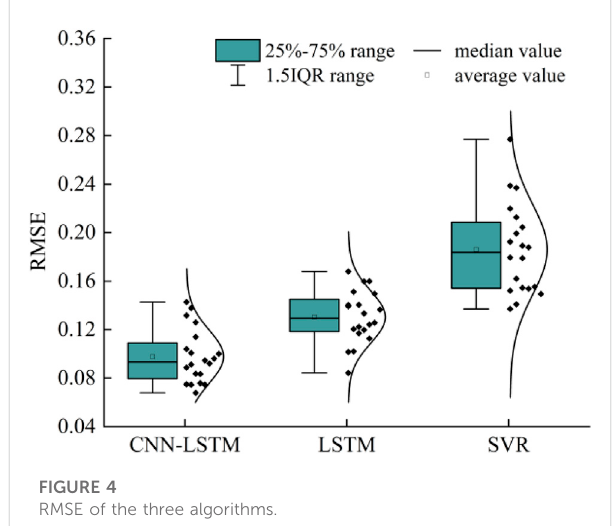
FIGURE 4 RMSE of the three